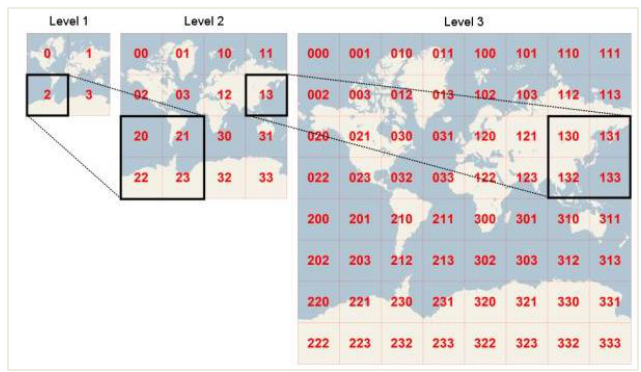
Figure 4. Tile-map pyramid.